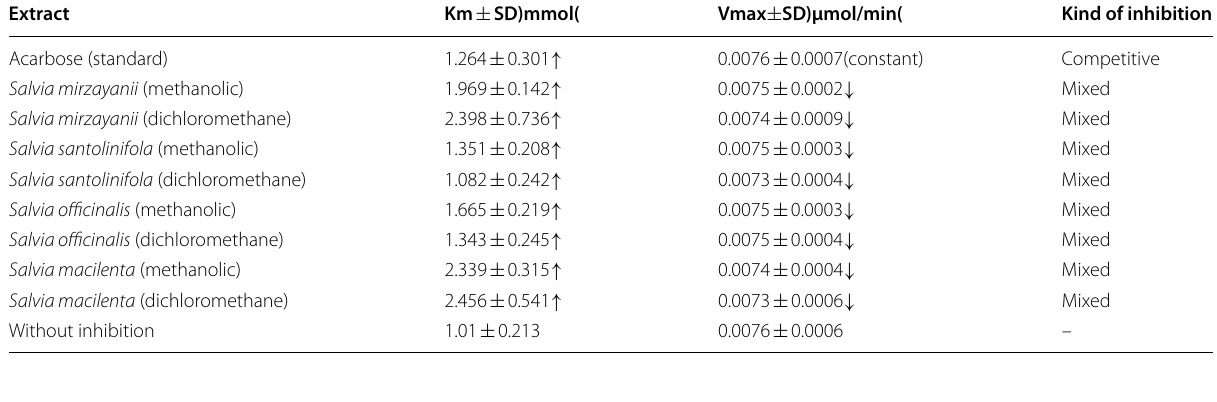
Table 2 Km SD and Vmax SD and the mode inhibition of the studied samples and acarbose ± ±